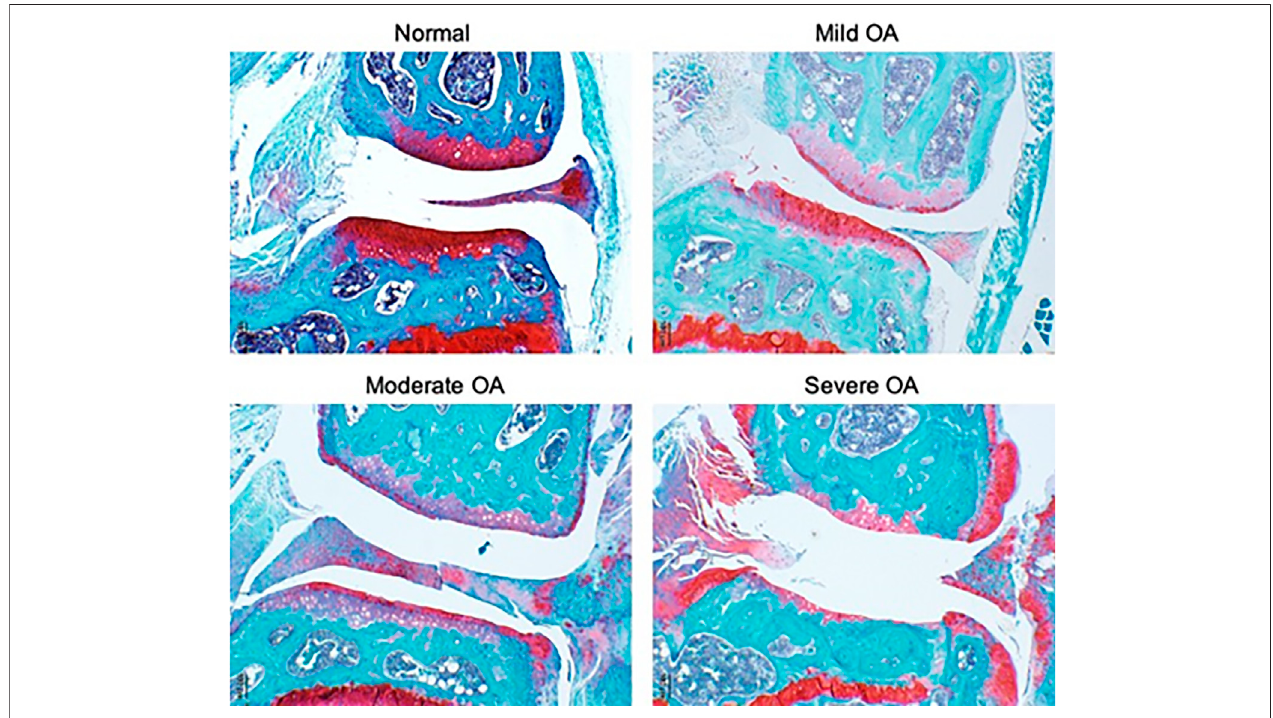
FIGURE 1 | Representative images of joint pathology in UM-HET3 mice. Normal includes joints with an OARSI score of 0 – .5, mild 1 – 2, moderate 3 – 4 and severe 5 – 6.